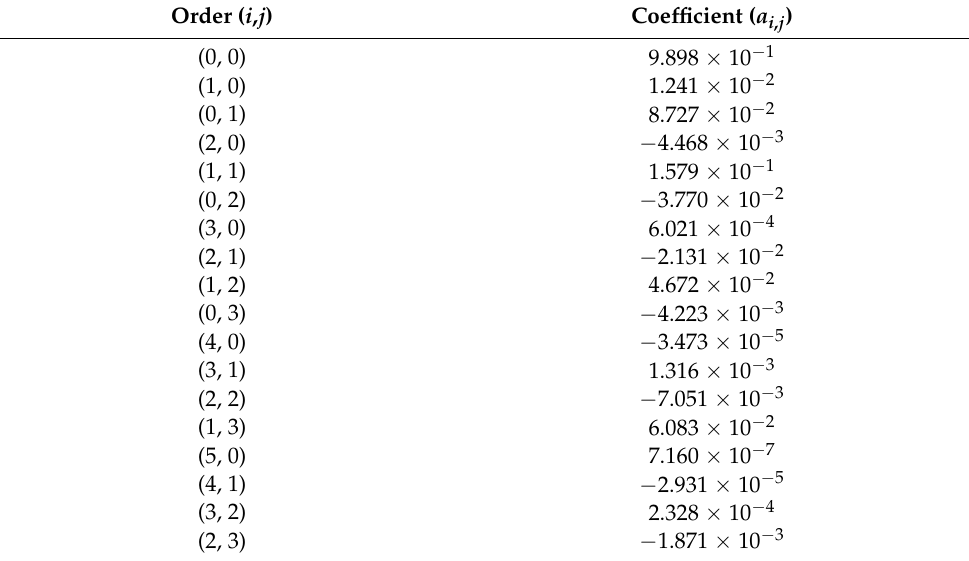
Table 2. Polynomial fitting